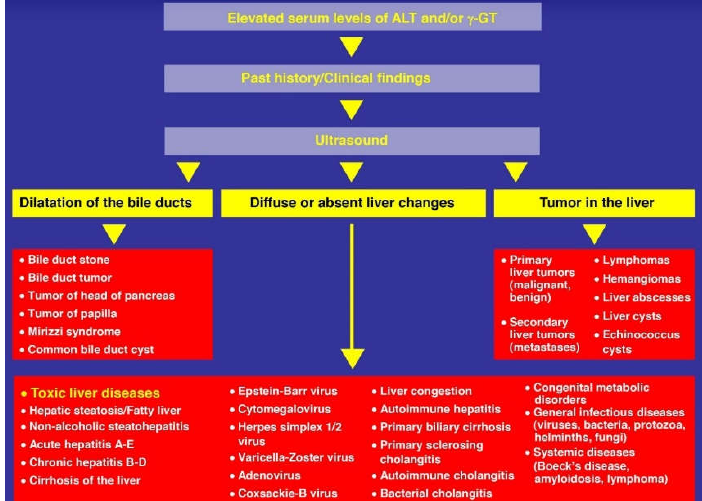
Figure 11. Differential diagnosis of alcoholic liver disease. Patients with a history of alcohol abuse presenting with increased liver values, require a careful diagnosis to exclude liver diseases that are unrelated to alcohol abuse.